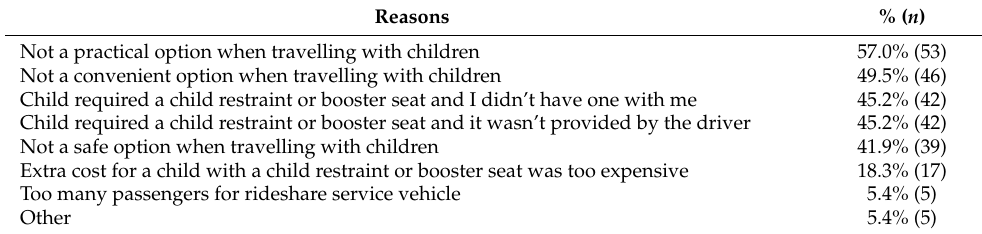
Table 5. Participants’ child-specific reasons for not travelling in a rideshare vehicle with their youngest child ( n =